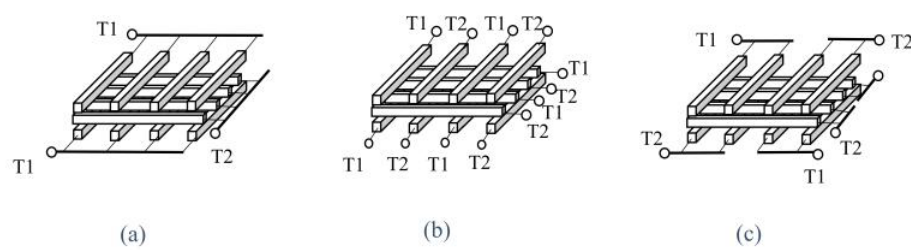
Figure 3. Three capacitor structures studied in this paper: vertical capacitor C V ( a ), and vertical and horizontal capacitors C VH ( b ) and C VH 2 ( c ).